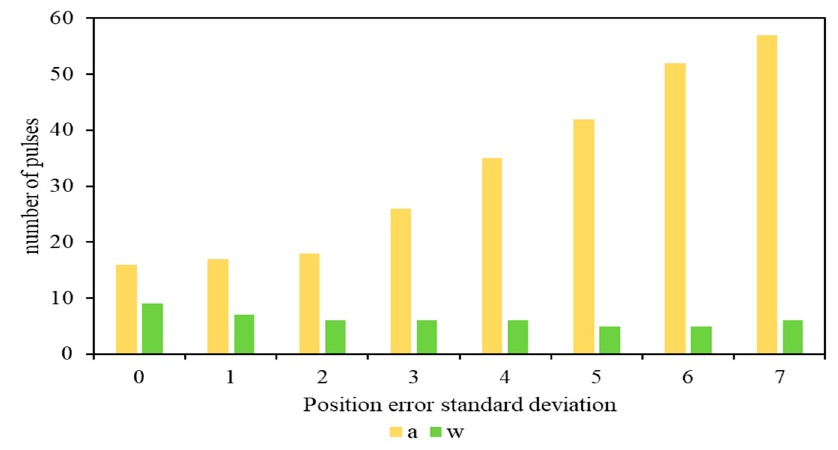
Figure 7. Comparison of control accuracy.